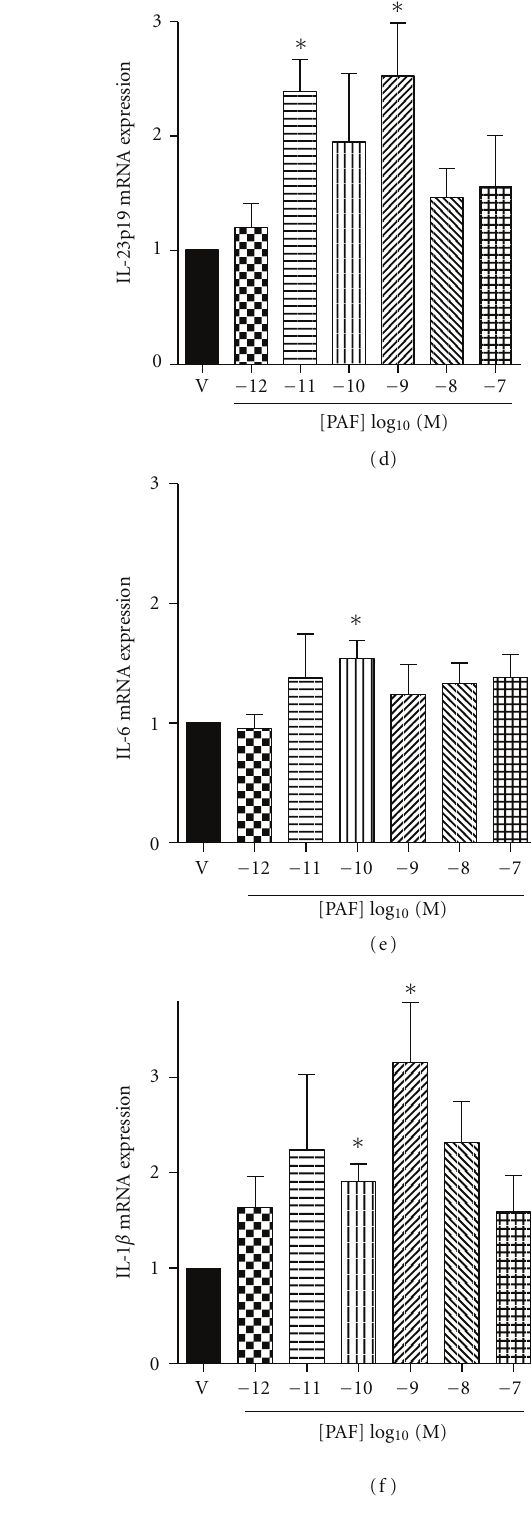
Figure 2: PAF-induced IL-23p19, IL-6, and IL-1 β mRNA expression in A431 keratinocytic cells (a, b, c) and normal human epidermal keratinocytes (NHEK; d, e, f). Cells were stimulated with graded concentrations of PAF or its vehicle (ethanol; V) for 4h. IL-23 p19 (a, d), IL-6 (b, e), and IL-1 β (c, f) mRNA was then measured by real-time quantitative PCR. Data (means ± SEM) are expressed as fold induction relative to vehicle control. n = 8; ∗ P < 0 . 05; ∗∗ P < 0 .